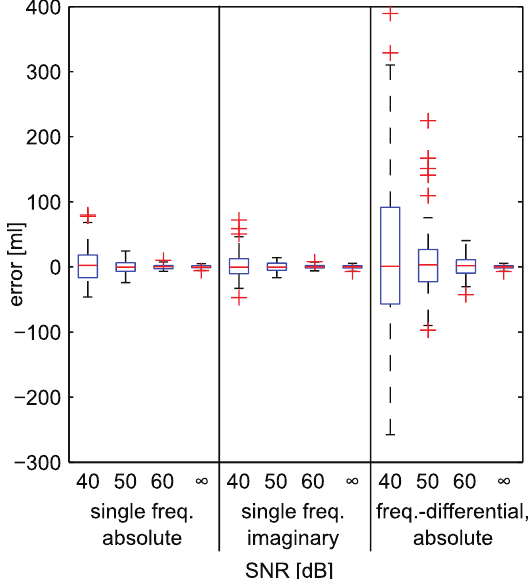
Fig.11: Noise susceptibility of the three methods for given SNR: Due to the smaller amplitude of the impedance differences, the multi-frequency method is much more susceptible to noise than the single frequency method.